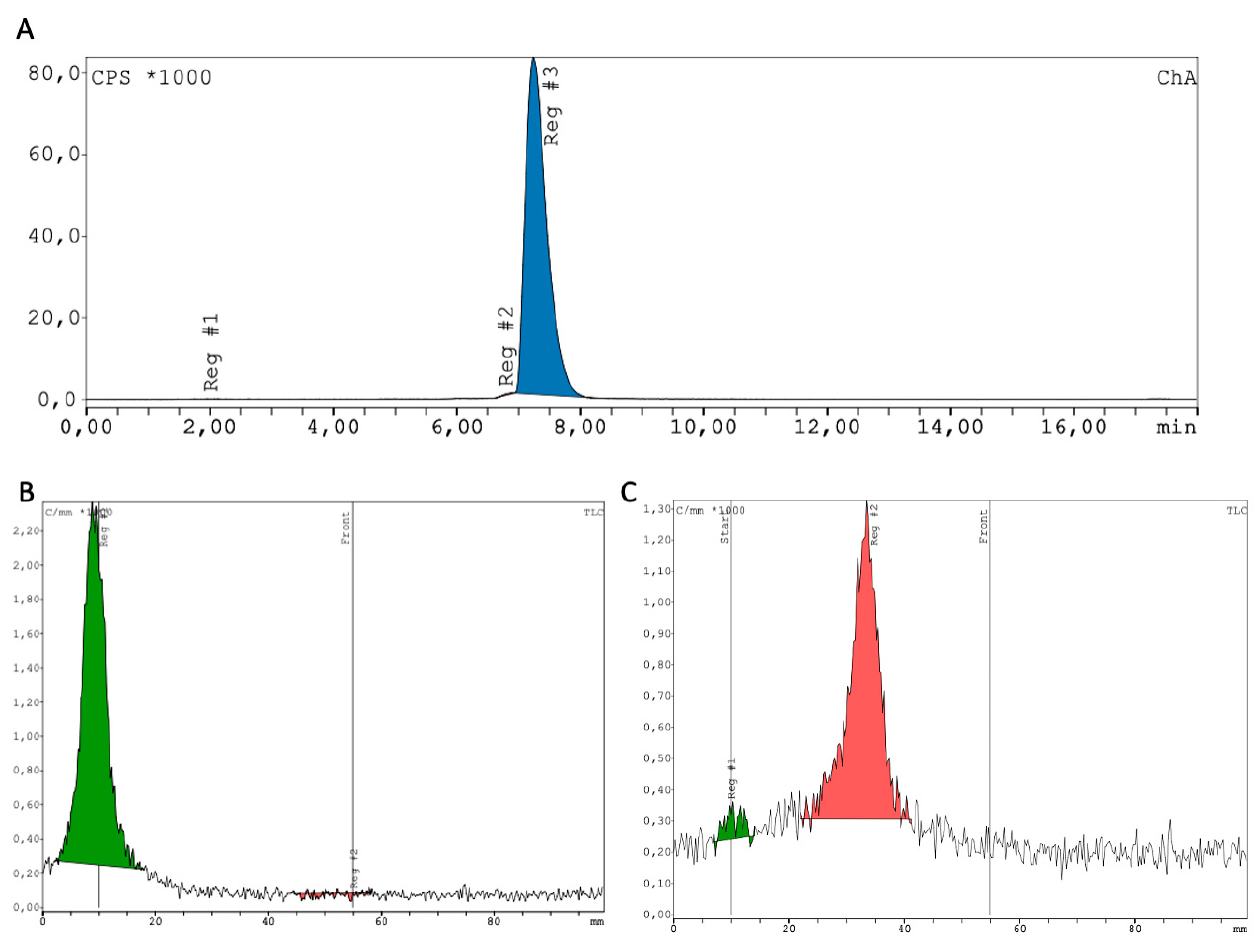
Figure 2. Quality control of [ 68 Ga]Ga-DATA 5m .SA.FAPi. ( A ) radio-HPLC; ( B ) radio-TLC in citric acid buffer; ( C ) radio-TLC in ammoniumacetate buffer and methanol (1:1 v / v ).